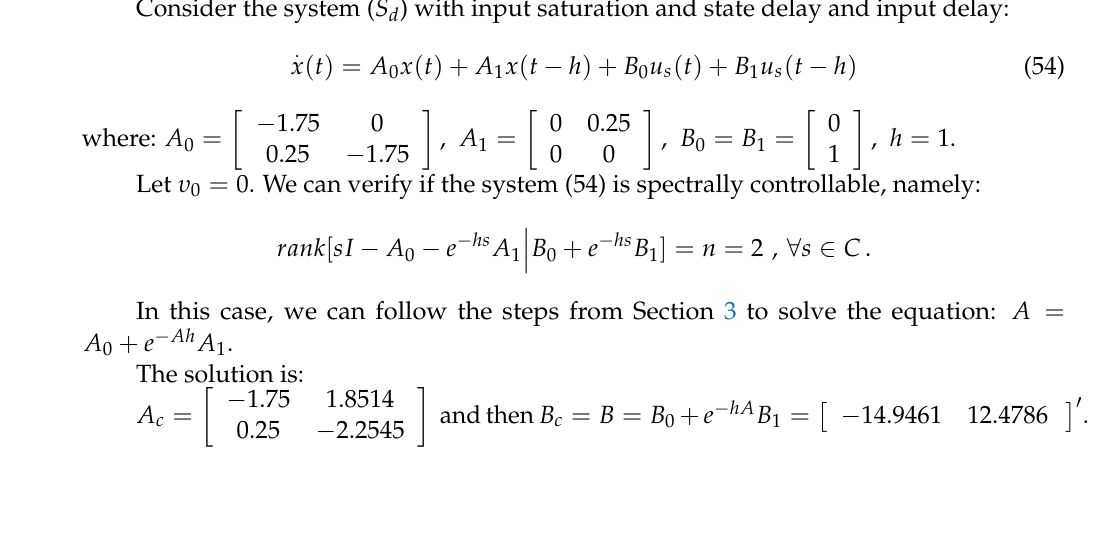
≤ u . Figure 6. Evolution of the states with | u | ≤ ≤ u .